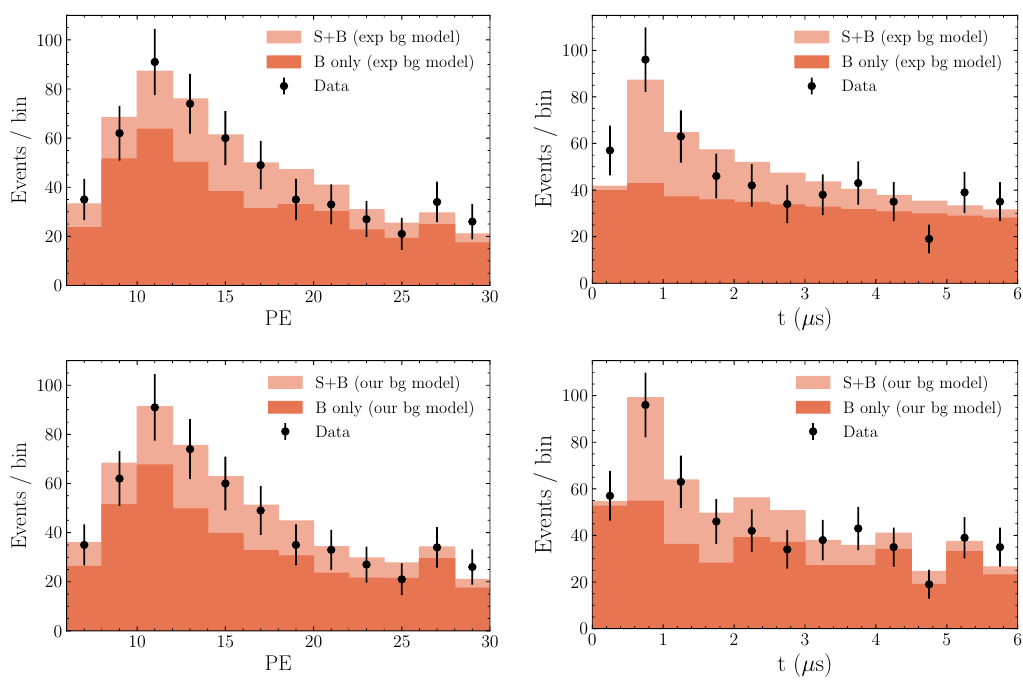
Figure 4 . Total events per bin in the beam-ON C sample, after being projected onto the time (left) and PE (right) and imposing the cuts 5 < PE 30 and t < 6 (cid:22) s. The observed data points (cid:20) are indicated with statistical error bars as in (cid:12)gure 2. The dark histograms show the expected background events for the steady-state contribution only. The upper panels have been obtained assuming that the time dependence of the background follows an exponential model, as in ref. [36], while the lower panels have been obtained using our model (which follows the time dependence of the AC events, see text for details). The light histograms show the predicted total number of events, after adding all signal and background contributions. To ease the comparison among di(cid:11)erent panels, in this (cid:12)gure the signal has been computed in all cases using the same FF and QF as in the data release [36]. All histograms shown correspond to the SM predicted event